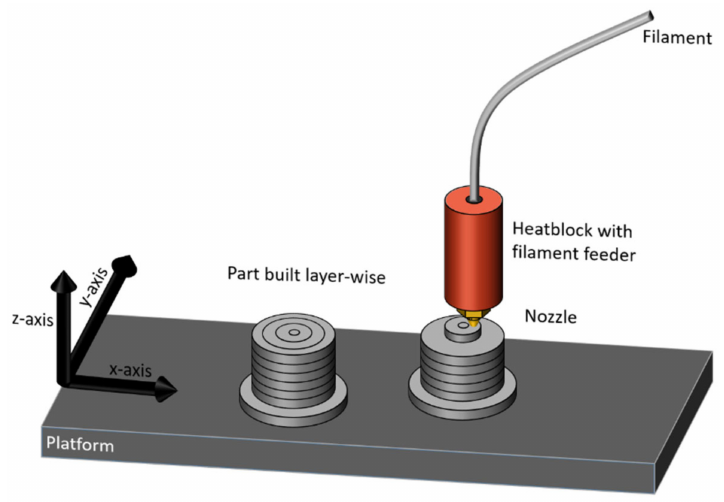
Figure 3. Schematic illustration of the